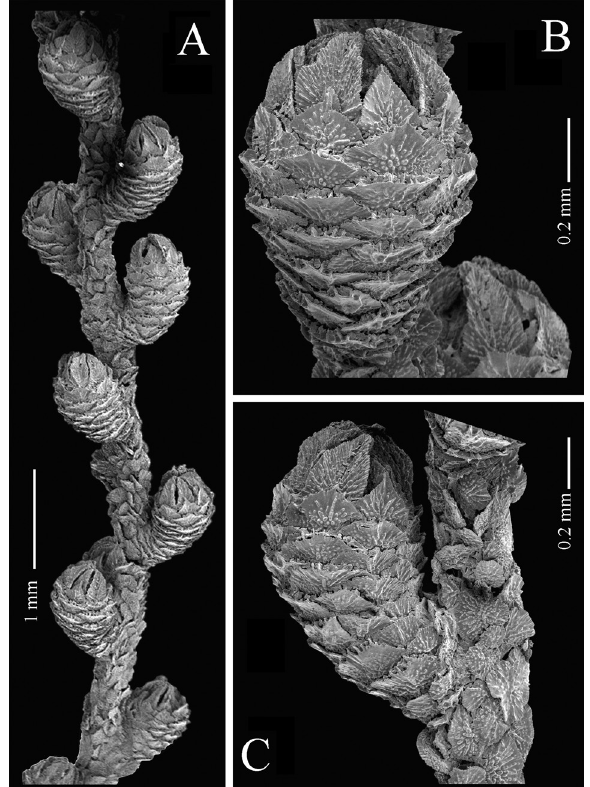
Fig . 3. – Thouarella regularis (Wright and Studer, 1889), lectotype (NHMUK 1889.5.27.60): A, detail of branchlet; B, polyp on abaxial view; C, polyp on lateral view.